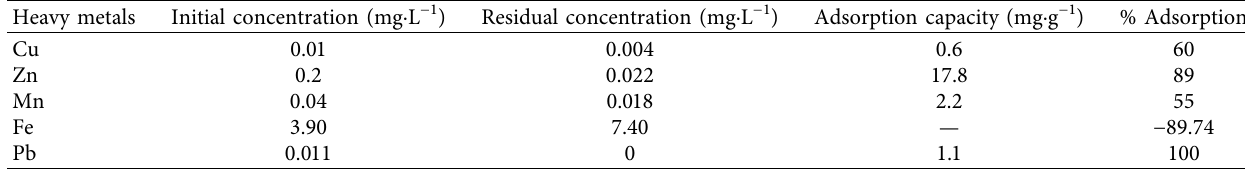
Table 9: Results of the adsorption test by smectic clay: adsorbent mass: 0.5g.